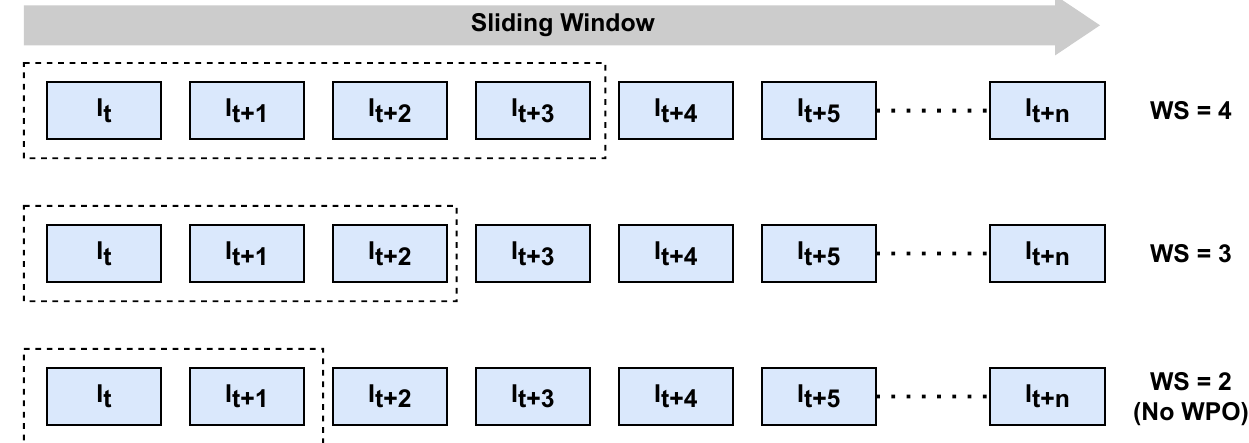
Figure 4. An illustration of the number of images taken as input to the network for WS = 2,3,4. All the networks used for comparison in this section are trained and tested with the same split, as mentioned in Section 3.3, with 30 percent of DA. The network with WS = 4 was the one used to compare with related work, and the data is derived from Section 3.4.